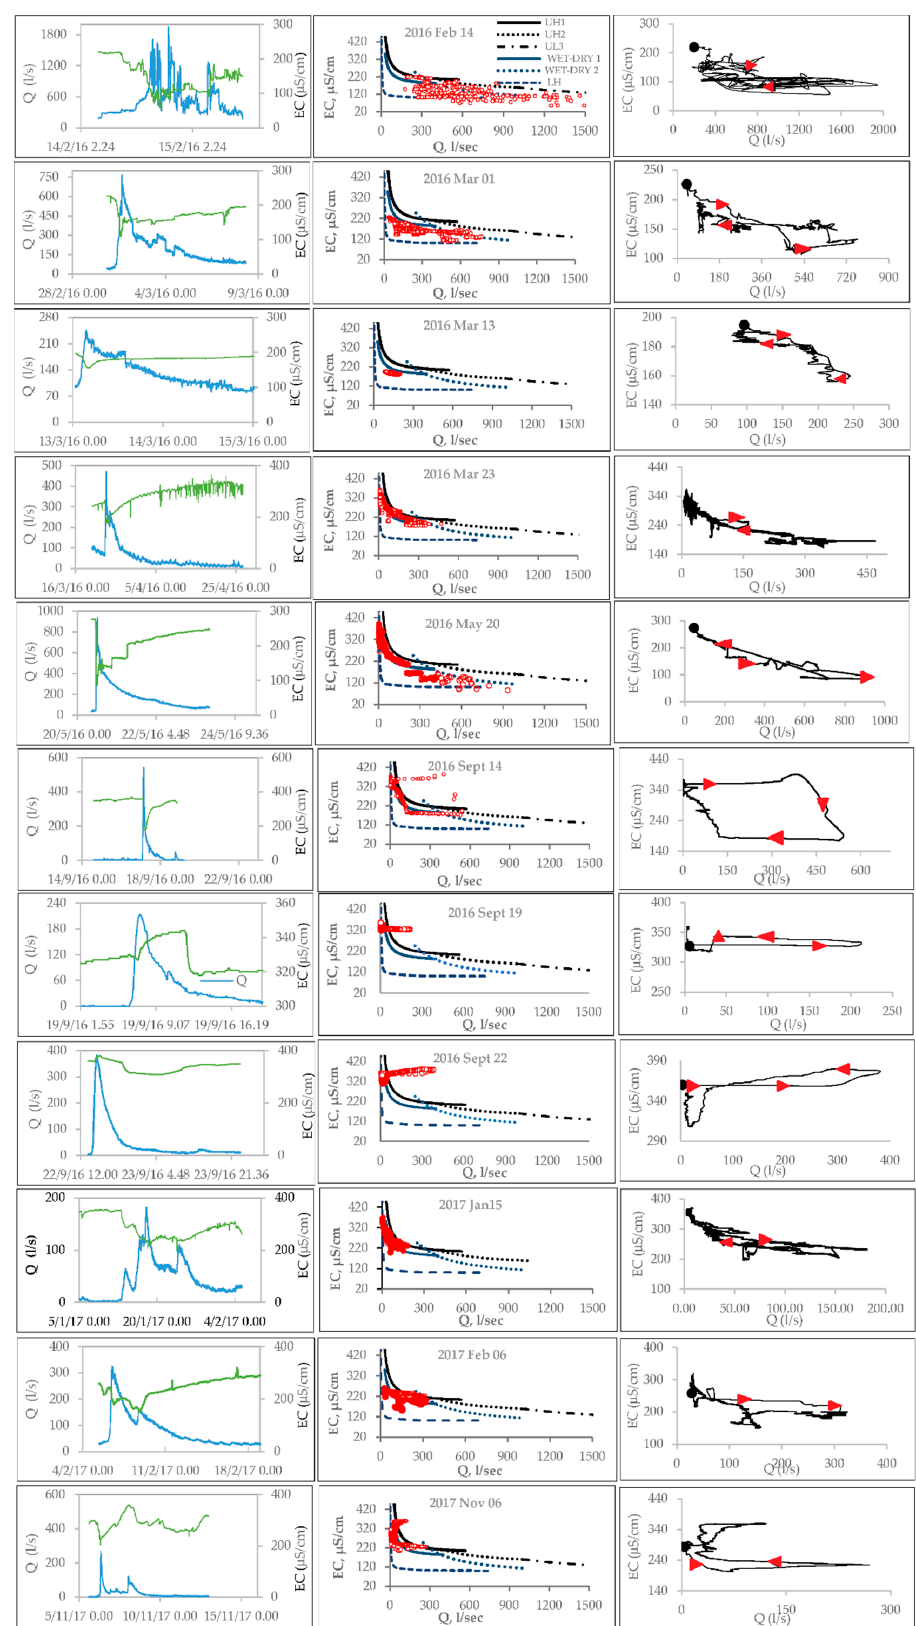
Figure 11. Hydro-chemograph, daily chart and hysteretic loop comparison of the selected events. (UH1—upper hyperbolic law 1, describing the Q-EC mixed value of groundwater and groundwater ridging; UH2—upper hyperbolic law 2, describing the Q-EC mixed value of groundwater,